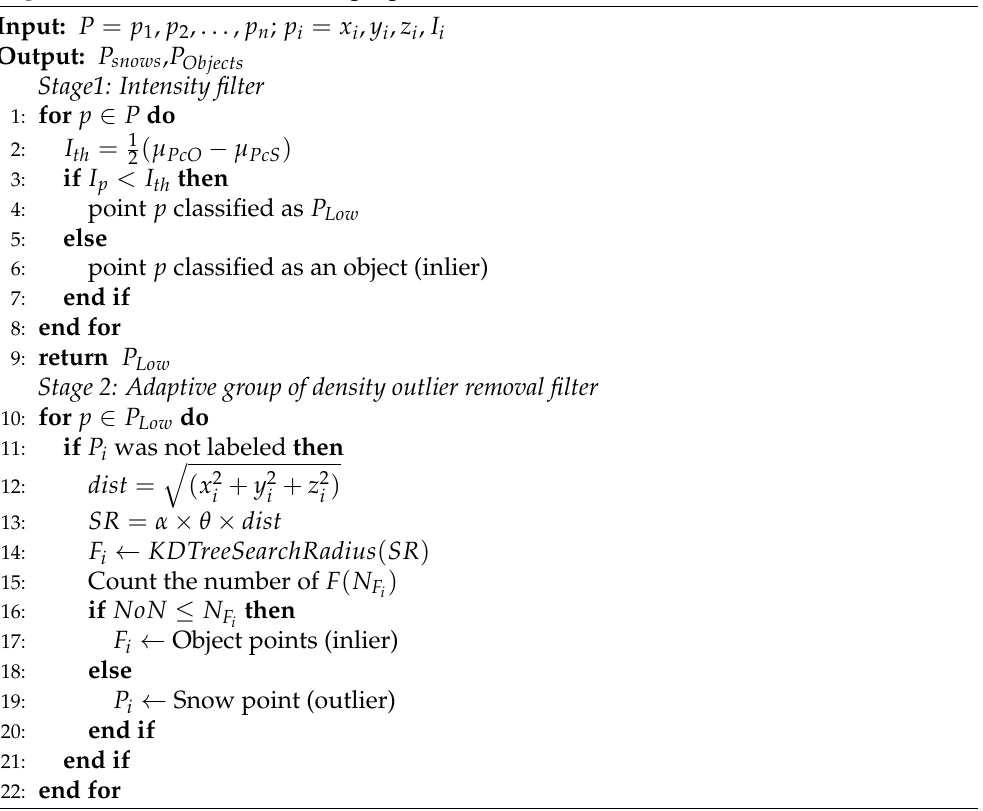
Algorithm 1 Pseudocode of our proposed